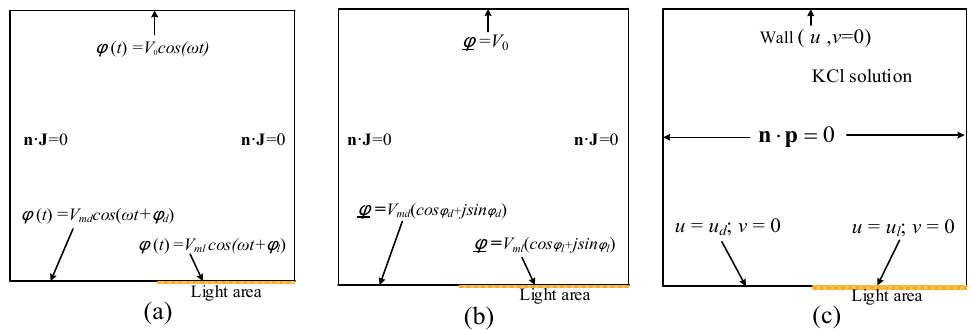
Figure 3. ( a ) Boundary condition for the simulating the transient distribution of quasi-static rotating e-field. ϕ ( t ) is the time-dependent electric potential. ( b ) Boundary condition for simulating the distribution of the time-averaged physical quantities of rotating e-field. ϕ is the complex phasor of the electric potential. J is the current density and n is the unit vector normal to the boundary. ( c ) Boundary condition for computing the distribution of fluidic velocity. p is the pressure; n is unit normal vector; u and v are horizontal and vertical components of the fluid velocity. u and u are the tangential ACEO slip velocity over the surface of light and dark area, respectively.